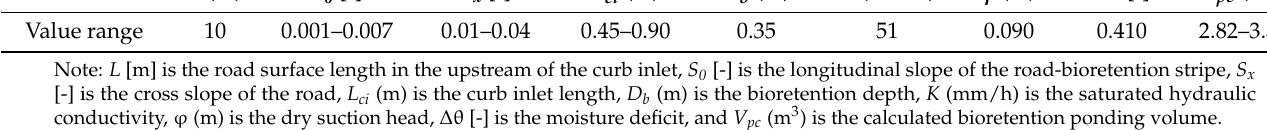
Table 2. Parameters of modeling cases for RB stripes with three types of curb inlet.